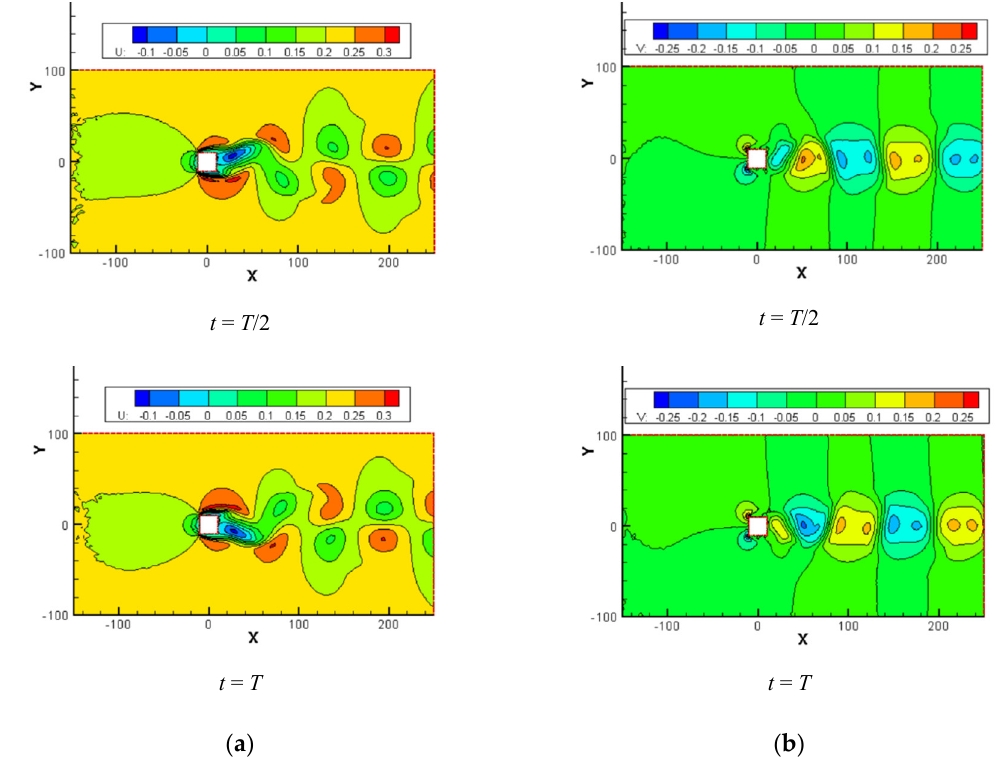
Figure 7. Contours of ( a ) U and ( b ) V of von Karmann vortex street at t = T / 2 and T , respectively. ( U -contours ranges from − 0.10 to 0.30 m / s with interval 0.05 m / s; V -contours ranges from –0.25 to 0.25 m / s with interval 0.05 m / s.) (unit: